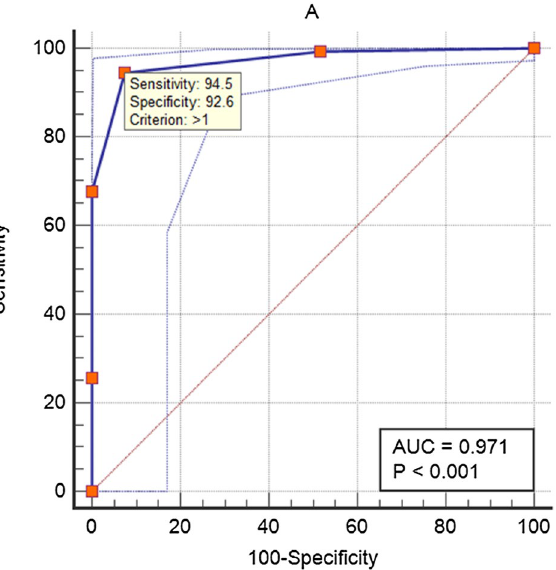
Figure 1. Evaluation of the area under the receiver-operating characteristic (ROC) curve (AUC) for a total score of > 1 in a classification model with a score of 1 for male, neutropenia (< 1500), aPTT prolongation (> 35 s), and normal C-reactive protein concentration (≤ 1.0 mg/dL) as factors among 33 patients with HGA and 221 patients with